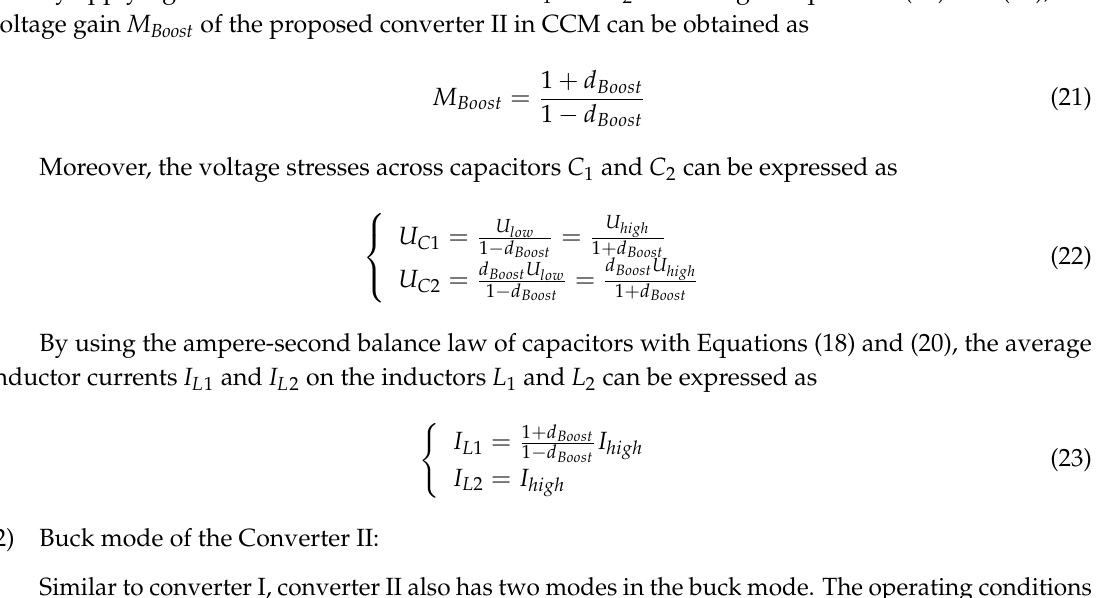
0 – t 1 ]. ( b ) [ t 1 – t 2